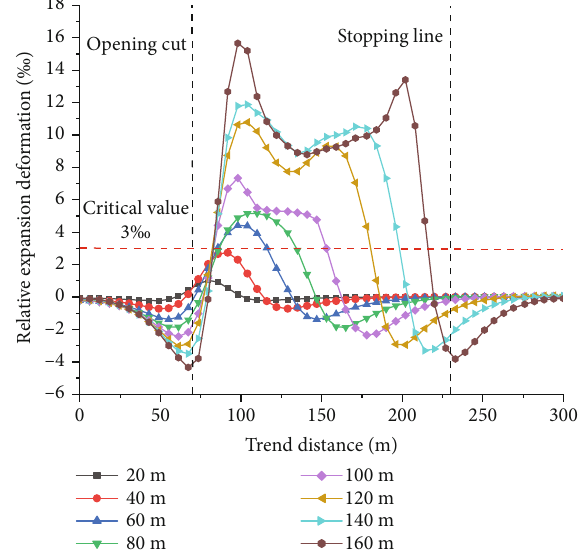
protected layer at di ff erent advancing distances. 19